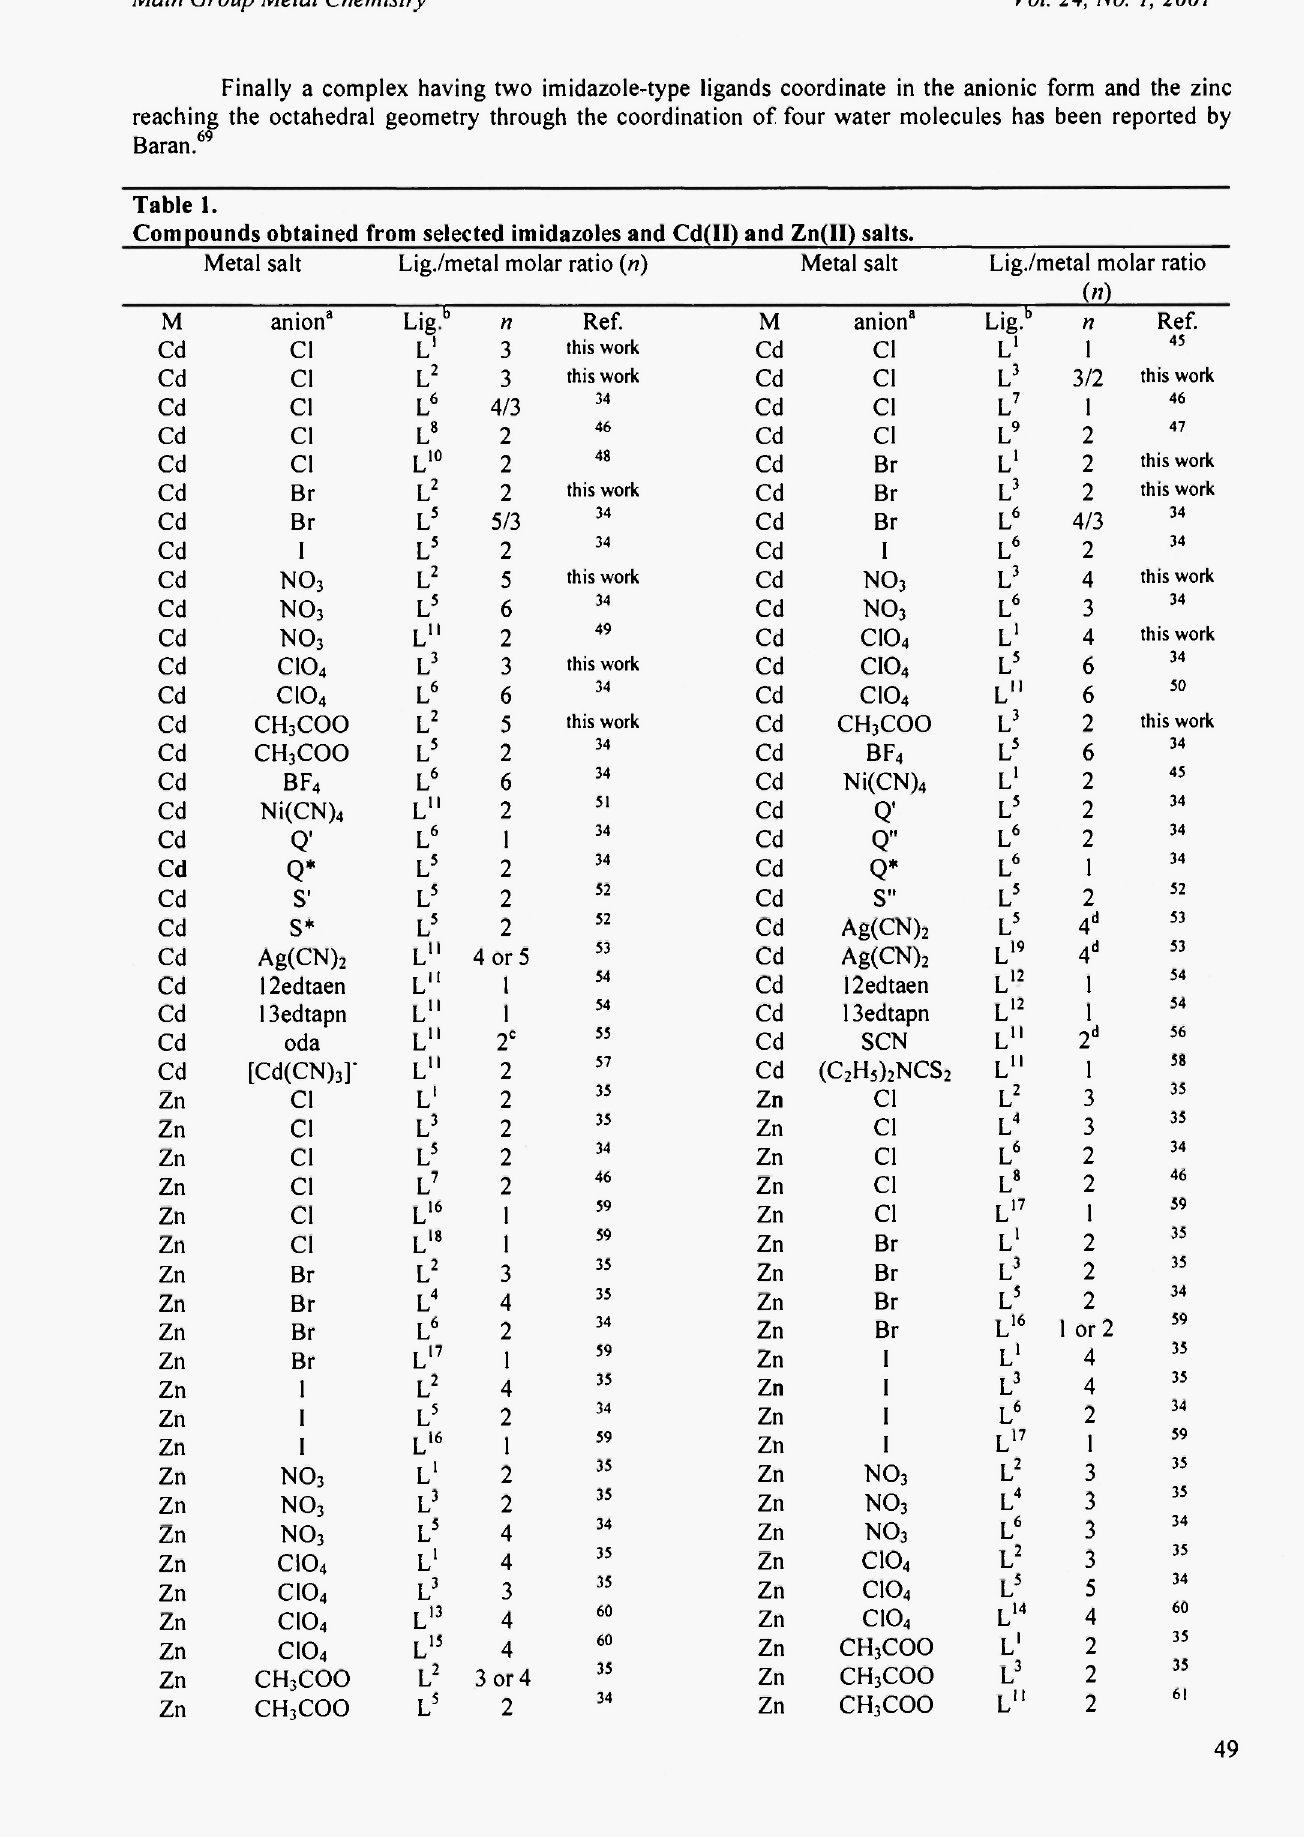
Compounds obtained from selected imidazoles and Cd(II) and Zn(II)